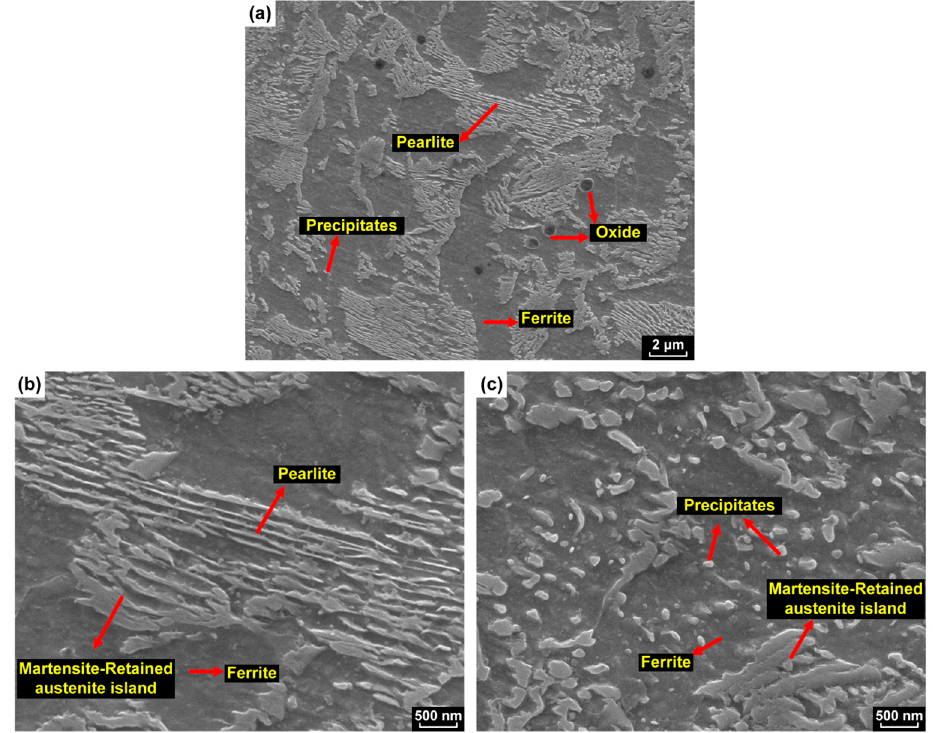
Figure 7. High-resolution micrograph of region C, ( a ) low magnification, ( b ) high magnification of pearlite, ( c ) high magnification of precipitates.